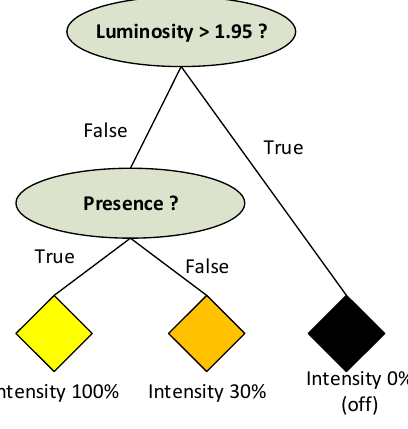
Figure 11. Decision tree implemented in Drools.